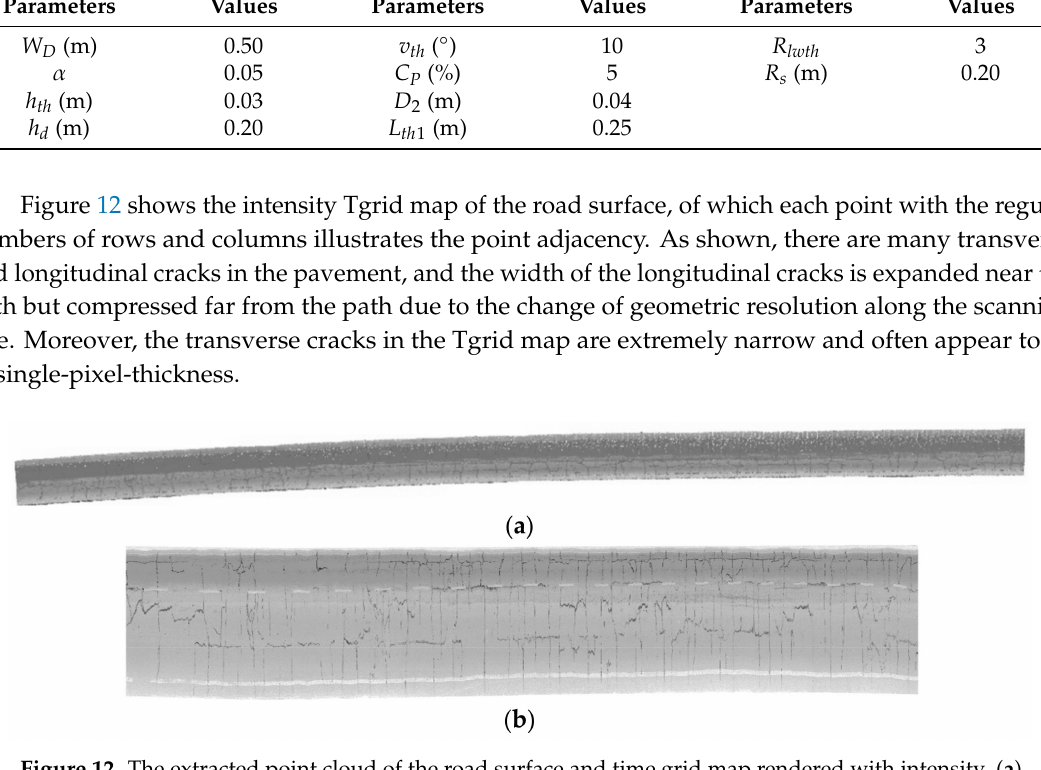
Figure 12. The extracted point cloud of the road surface and time grid map rendered with intensity. ( a ) The extracted point cloud of the road surface, and ( b ) the intensity-based Tgrid map of the road surface.